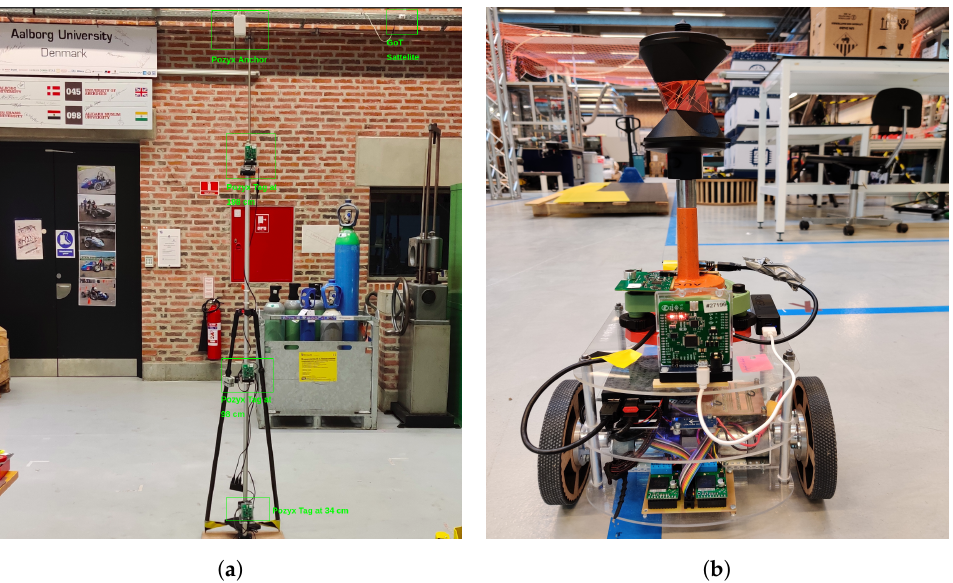
Figure 1. ( a ) Tripod for static measurements. Tags are placed on tripod at 3 heights. The background shows the beacons of the 2 positioning systems. ( b ) Mobile platform for dynamic measurements. Mobile robot carries both tags to be tracked. The optical prism (orange) is for the reference